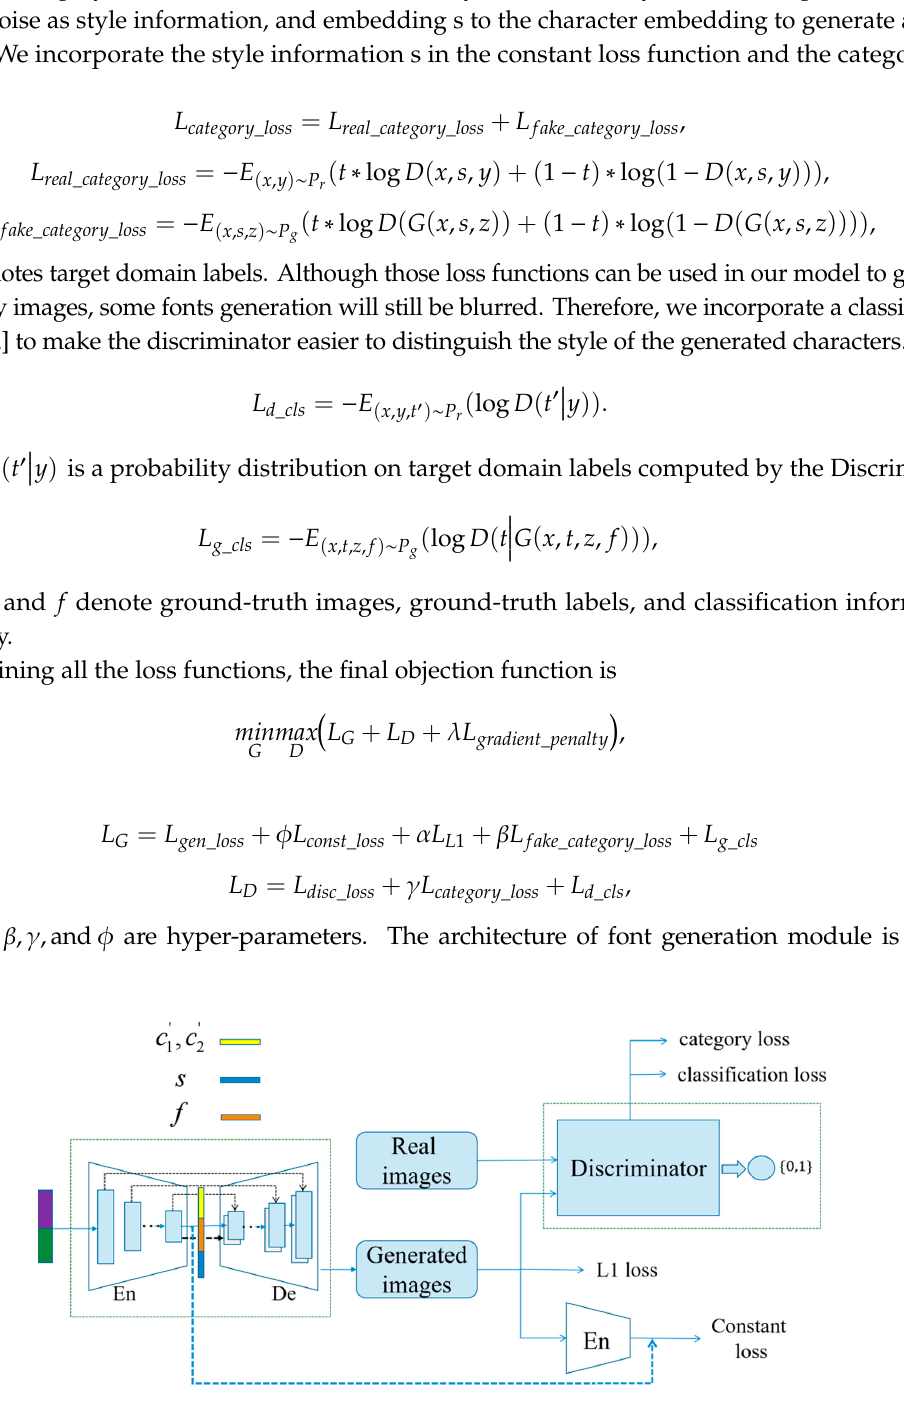
(cid:48) ) , the output of which can ,c (cid:48) 1 2